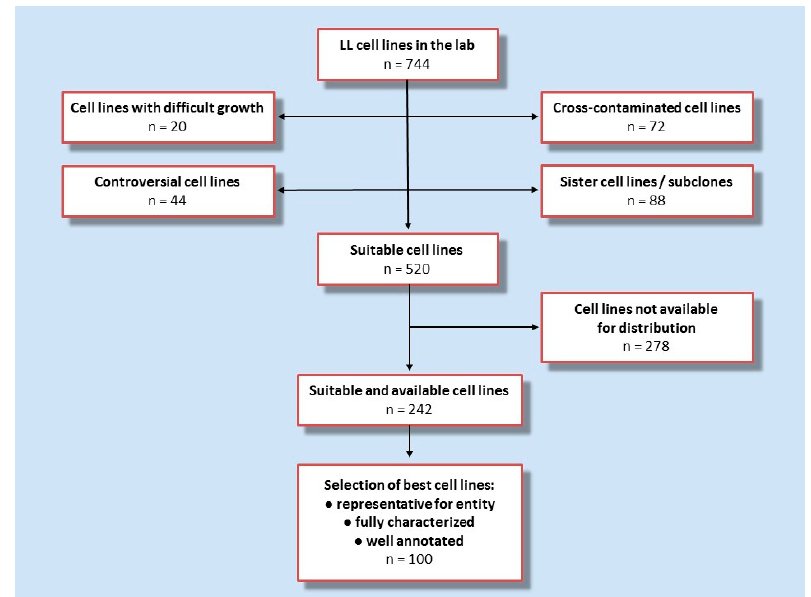
Figure1. FlowchartshowingthestrategyfortheassemblyofLL-100panel. Dataon,